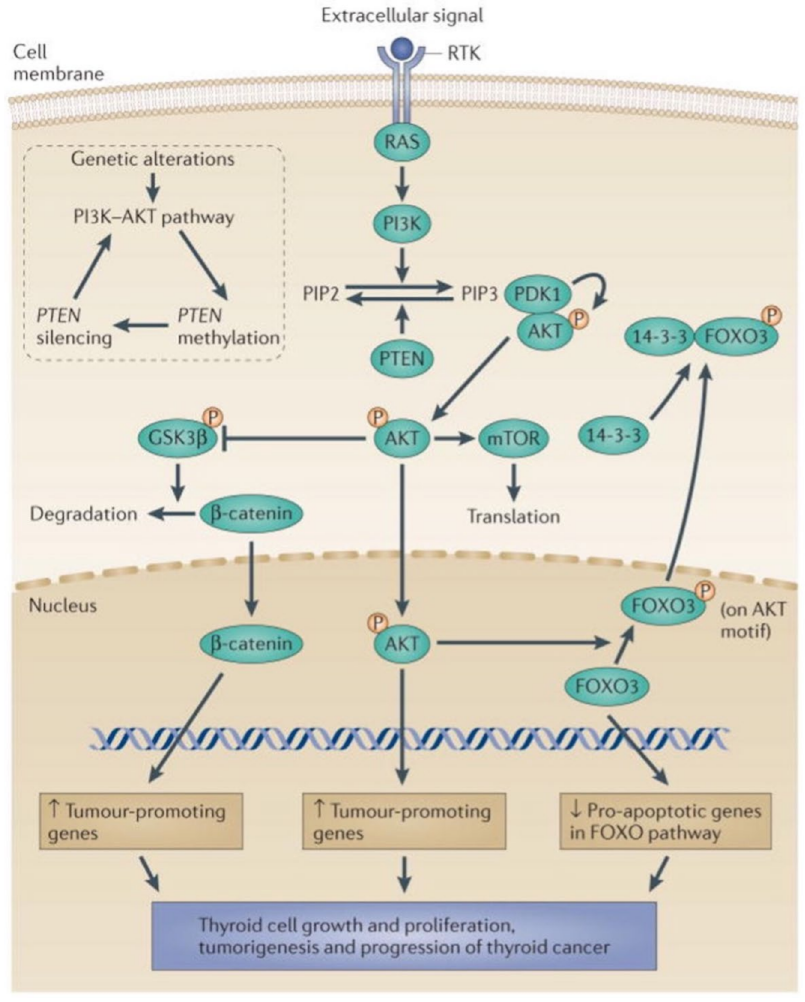
Figure 2. The PI3K-AKT and related pathways in thyroid cancer. Extracellular signals activate receptor tyrosine kinases (RTKs), leading to the activation of RAS and PI3K. Activated PI3K catalyzes the conversion of phosphatidylinositol (4,5)-bisphosphate (PIP2) to phosphatidylinositol (3,4,5)- trisphosphate (PIP3). PIP3 activates 3-phosphoinositide-dependent protein kinase 1 (PDK1; also known as PDPK1), which consequently associates with AKT and leads to phosphorylation (P) and the activation of AKT by PDK1. Phosphorylated AKT enters the nucleus, where it induces tumor-promoting genes. In the cytoplasm, phospho-AKT also activates other signaling molecules or pathways, including the mTOR pathway, which has an important role in tumorigenesis. Phospho- AKT can also directly phosphorylate glycogen synthase kinase 3 β (GSK3 β ), relieving the GSK3 β - mediated suppression of β -catenin. Consequently, β -catenin can enter the nucleus, where it promotes the expression of tumor-promoting genes. In the nucleus, phospho-AKT can phosphorylate forkhead box O3 (FOXO3) on its AKT-specific motif. This phosphorylated FOXO3 is translocated out of the nucleus to the cytoplasm, where it binds 14-3-3 proteins to be sequestered in the cytoplasm, thus terminating the pro-apoptotic activities of the FOXO3 pathway. The downward arrow for the FOXO activities in the nucleus in the figure indicates this negative effect of AKT on pro-apoptotic genes in the FOXO pathway, which would otherwise be upregulated by the FOXO3 pathway. The major negative regulatory mechanism of the PI3K–AKT pathway is PTEN, which is a phosphatase that converts PIP3 to PIP2, thus terminating the activation of the pathway. The inset shows the self- enhancement mechanism of PI3K–AKT signaling, resulting in a loss of termination of the signaling. Figure reprinted from Ref. [79], by